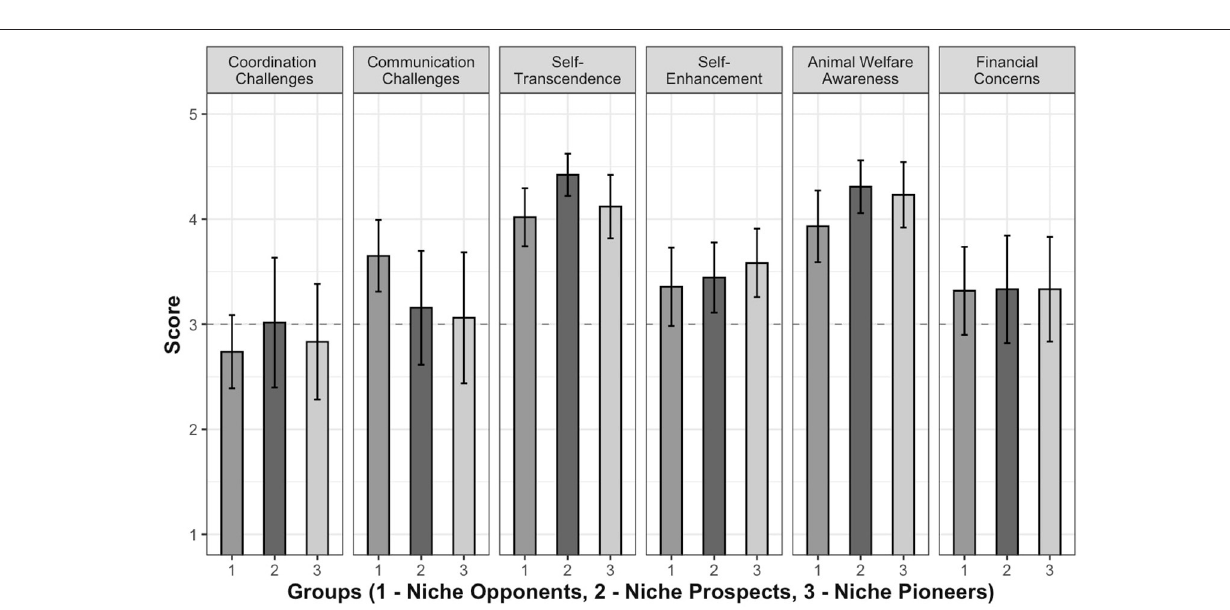
FIGURE 2 | Scores of most important barriers and motivators to retailer groups. Challenges (Coordination- and Marketing-related) on a scale from 1 = “absolutely unproblematic” to 5 = “extremely problematic”. Values (Self-Transcendence and Self-Enhancement) on a scale from 1 = “not like me at all” to 5 = “very much like me”. Concern for Animal Welfare and Financial Concerns on a scale from 1 = “not true at all” to 5 = “totally true”. Differences according to ANOVA: Communication-related challenges: [ F (2,46) = 2.11, p = 0.133]; Coordination-related challenges: [ F (2,49) = 0.38, p = .687]; Self-transcendence: [ F (2,52) = 2.91, p = 0.064], Self-enhancement: [ F (2,51) = 0.44, p = 0.646], Concern for animal welfare: [ F (2,50) = 1.94, p = 0.154], Financial Concerns: [ F (2,52) = < 0.1, p =